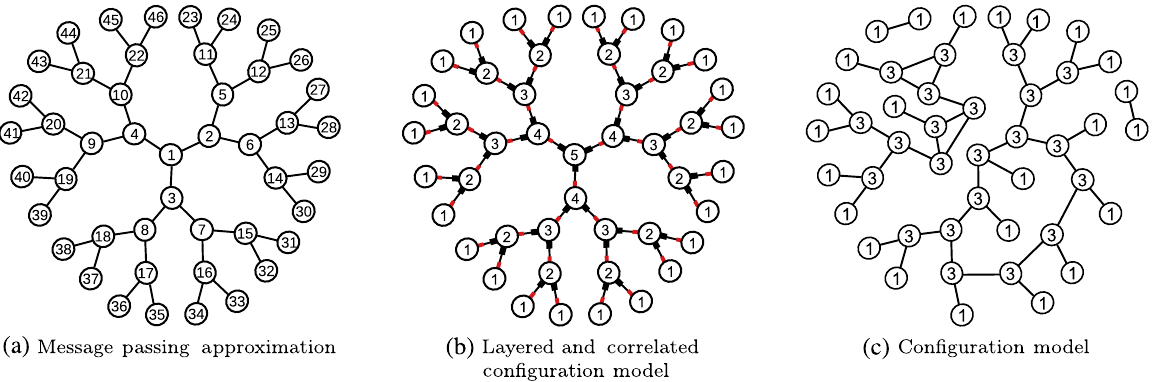
FIG. 2. Compression of a perfect tree with different network models. (a) The message passing approximation assigns a unique ID to every node and preserves the full structure of the tree. (b) The layered and correlated configuration model assigns an ID to every node corresponding to its degree and its position in the core-periphery structure of the network. Degrees are not shown to lighten the presentation. Stubs are colored according to the layer to which they point: red if they point to more central layers and black if they point to the previous layer (different sizes are used for a clearer contrast between black and red stubs). There are no green stubs in this example. (c) The configuration model assigns an ID to every node according to its degree before randomly connecting them, thereby destroying the mesoscopic and macroscopic structure of the original network. The correlated configuration model fixes the number of links between different degree classes, and would therefore prohibit components formed by two nodes with degree 1, but would otherwise be very similar to the configuration model shown green stubs, respectively. For instance, a link between nodes in layers 3 and 5 consists in a red stub stemming out of the node in layer 3 paired with a green stub belonging to the node in layer 5. Note that a link between two given layers can only consist in a unique pair of stub colors, and the only allowed combinations are red-red, red-black, and red-green.